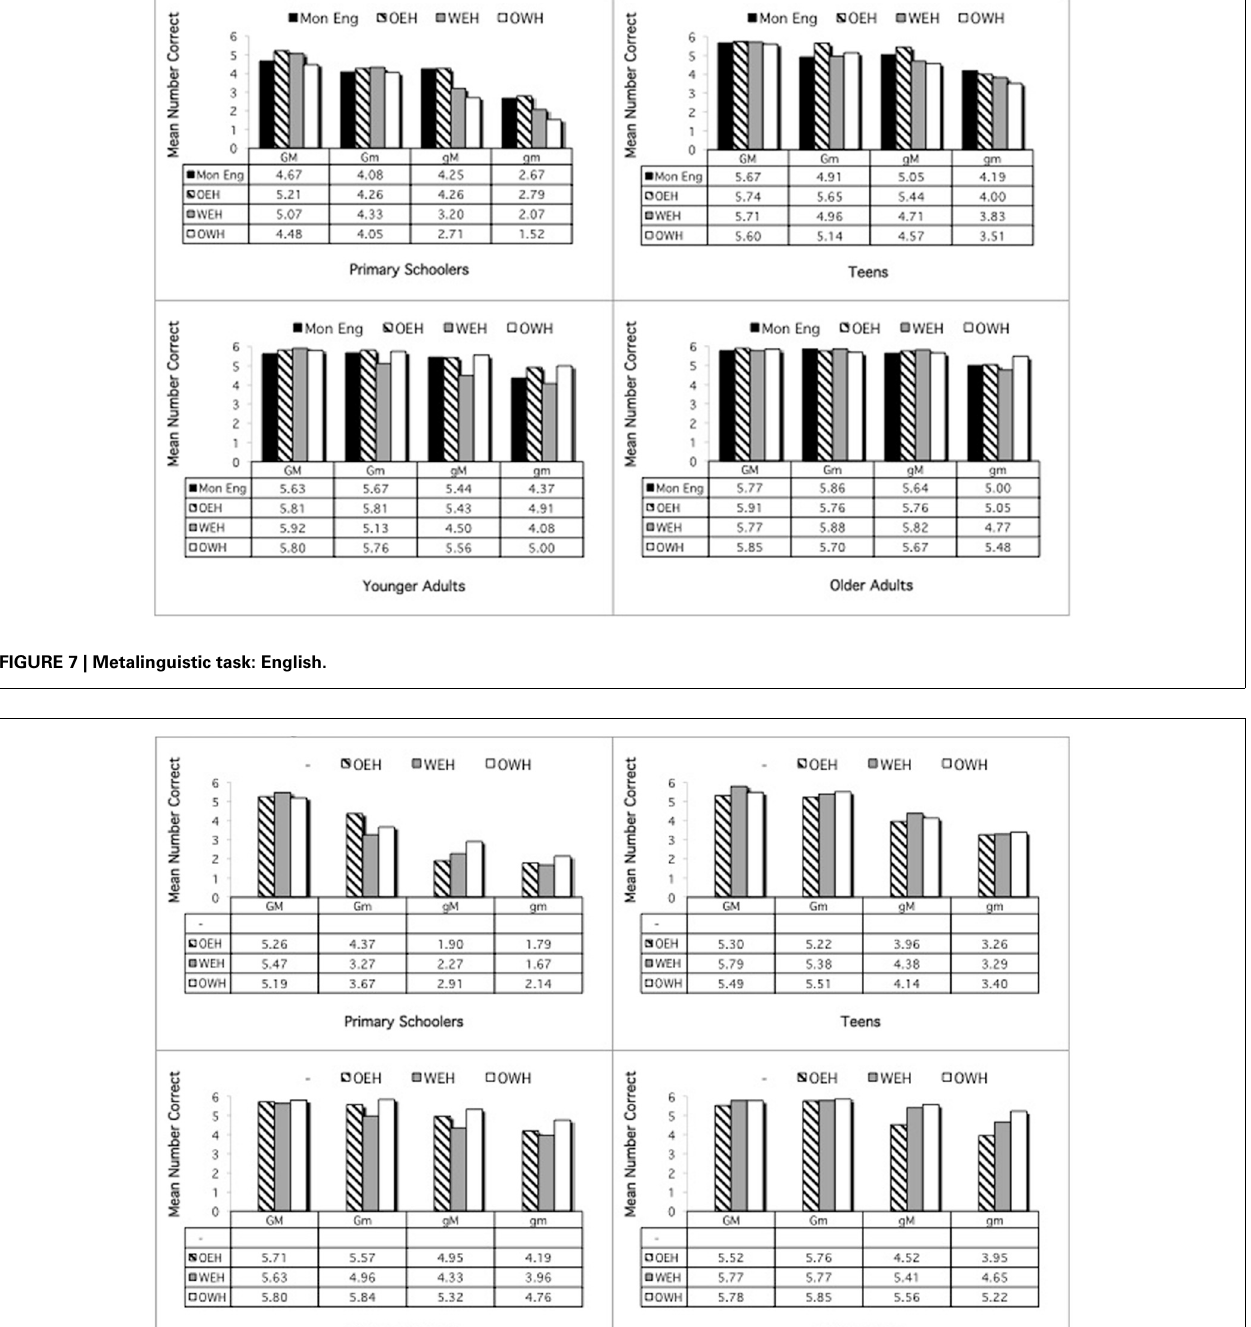
accordance with predictions related to language ability, in con- trast, home language, when it mattered, showed an advantage in the direction of the bilingual group that was dominant in the given language. That is, for English, the OEH children performed